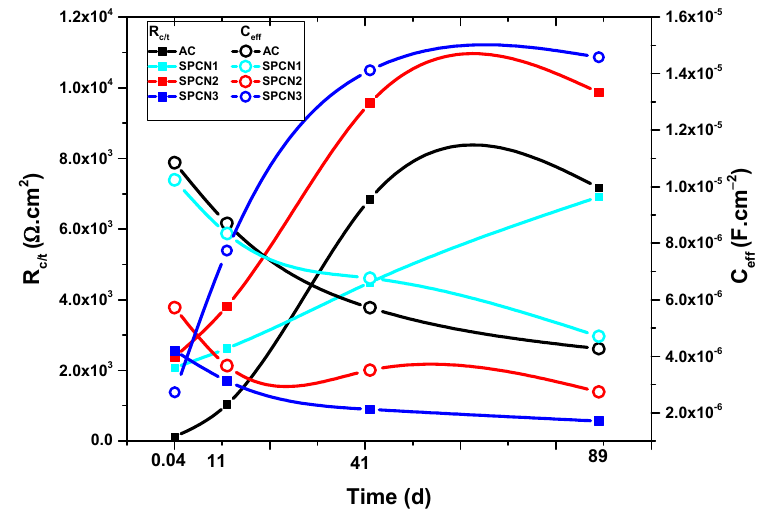
Figure 8. Electrochemical parameters plot of R c/t and C eff with exposure periods in 3.5 wt.% NaCl solution.